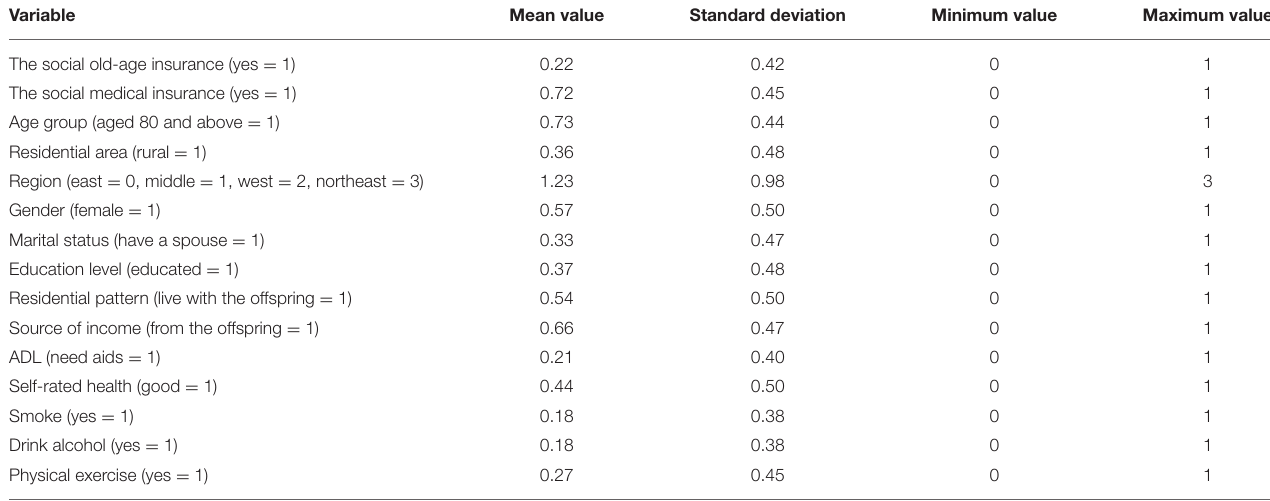
TABLE 1 | The settings of variables and the distribution in the base period. Variable